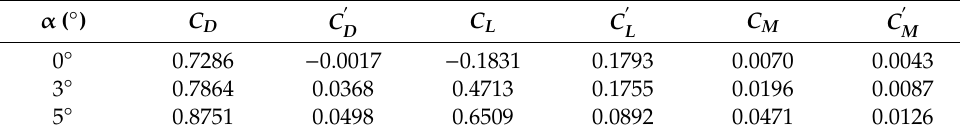
Table 3. Aerodynamic force coe ffi cients and derivatives for the construction